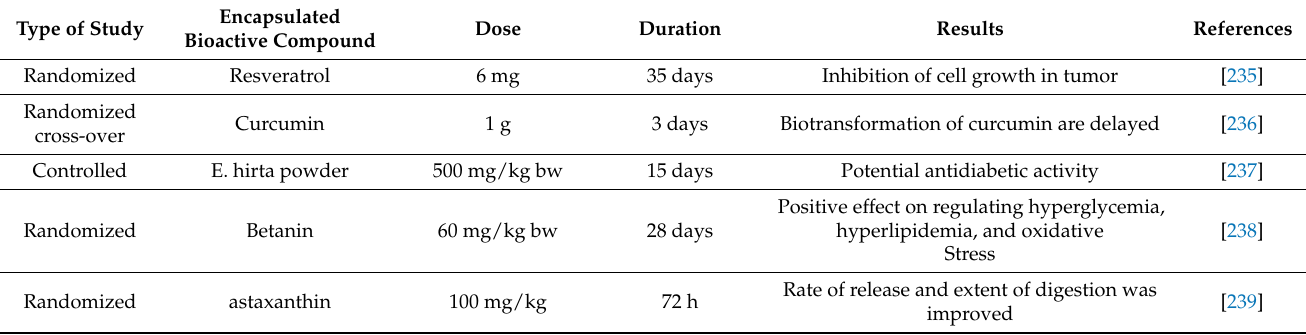
Table 4. In-vivo studies showing pharmacological effect and release stability of encapsulated bioactive